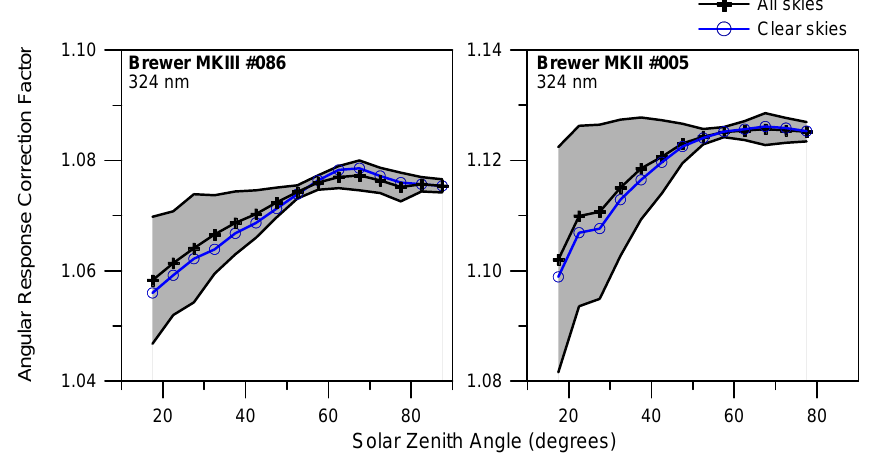
Fig. 4. Average correction factors for the angular response error of the two Brewer spectroradiometers at 324 nm under all skies (crosses) and clear skies (cycles), as a function of solar zenith angle. The shaded area represents the 1 σ variability for the all-sky average correction factor. The variability of the clear-sky correction factor is very similar and is not